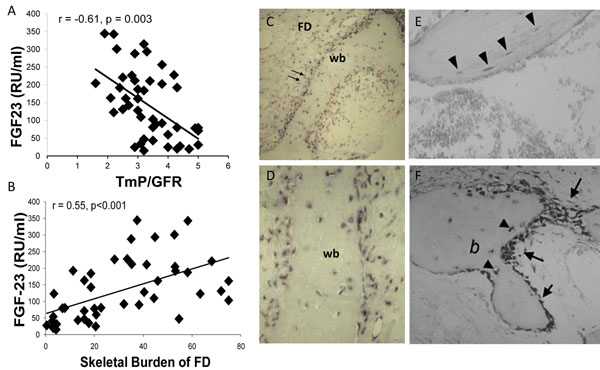
Panel A demonstrates the relationship and significant negative correlation between serum FGF23 and the degree of phosphate wasting, supporting the concept that FGF23 is responsible for the phosphate wasting that can be seen in association with FD. Panel B depicts the relationship and significant positive correlation between the serum FGF23 and the skeletal burden of FD, which supports the hypothesis that the FD tissue is the source of FGF23. Panels C&D are low and high power views, respectively, of in situ hybridization studies using probes for FGF23 that demonstrate that FD tissue demonstrates high levels of FGF23 transcripts. Panels E&F show high levels of FGF23 transcripts in bone from control, normal bone; E osteocytes and F osteoblasts in healing fracture callus. FD = fibrous dysplasia, wb = woven bone, b = bone, double arrows designate FD stromal cells, arrow heads designate osteocytes, single arrows designate osteoblasts. Adapted from reference [17].